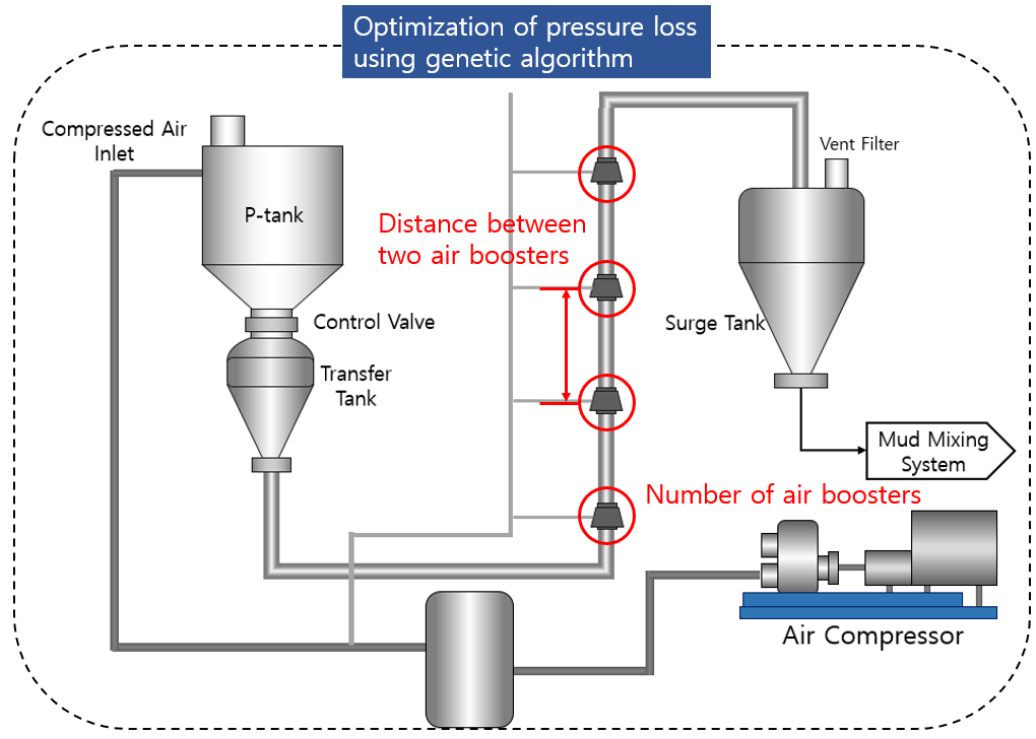
Figure 11. Optimal positions of air boosters for pressure loss minimization.